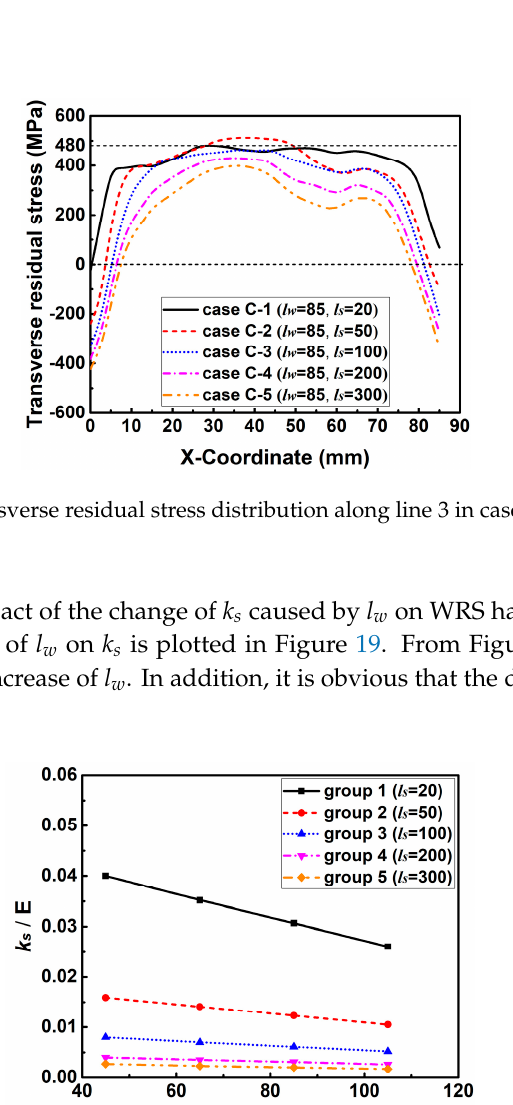
( d ) Figure 16. Transverse residual stress distributions along line 2 in the cases of each group with varied slit length ( l s ) while the weld length ( l w ) is kept constant: ( a ) Group A; ( b ) group B; ( c ) group C; ( d ) group D. Figure 17. The contour of peak temperature distribution in case B-3.